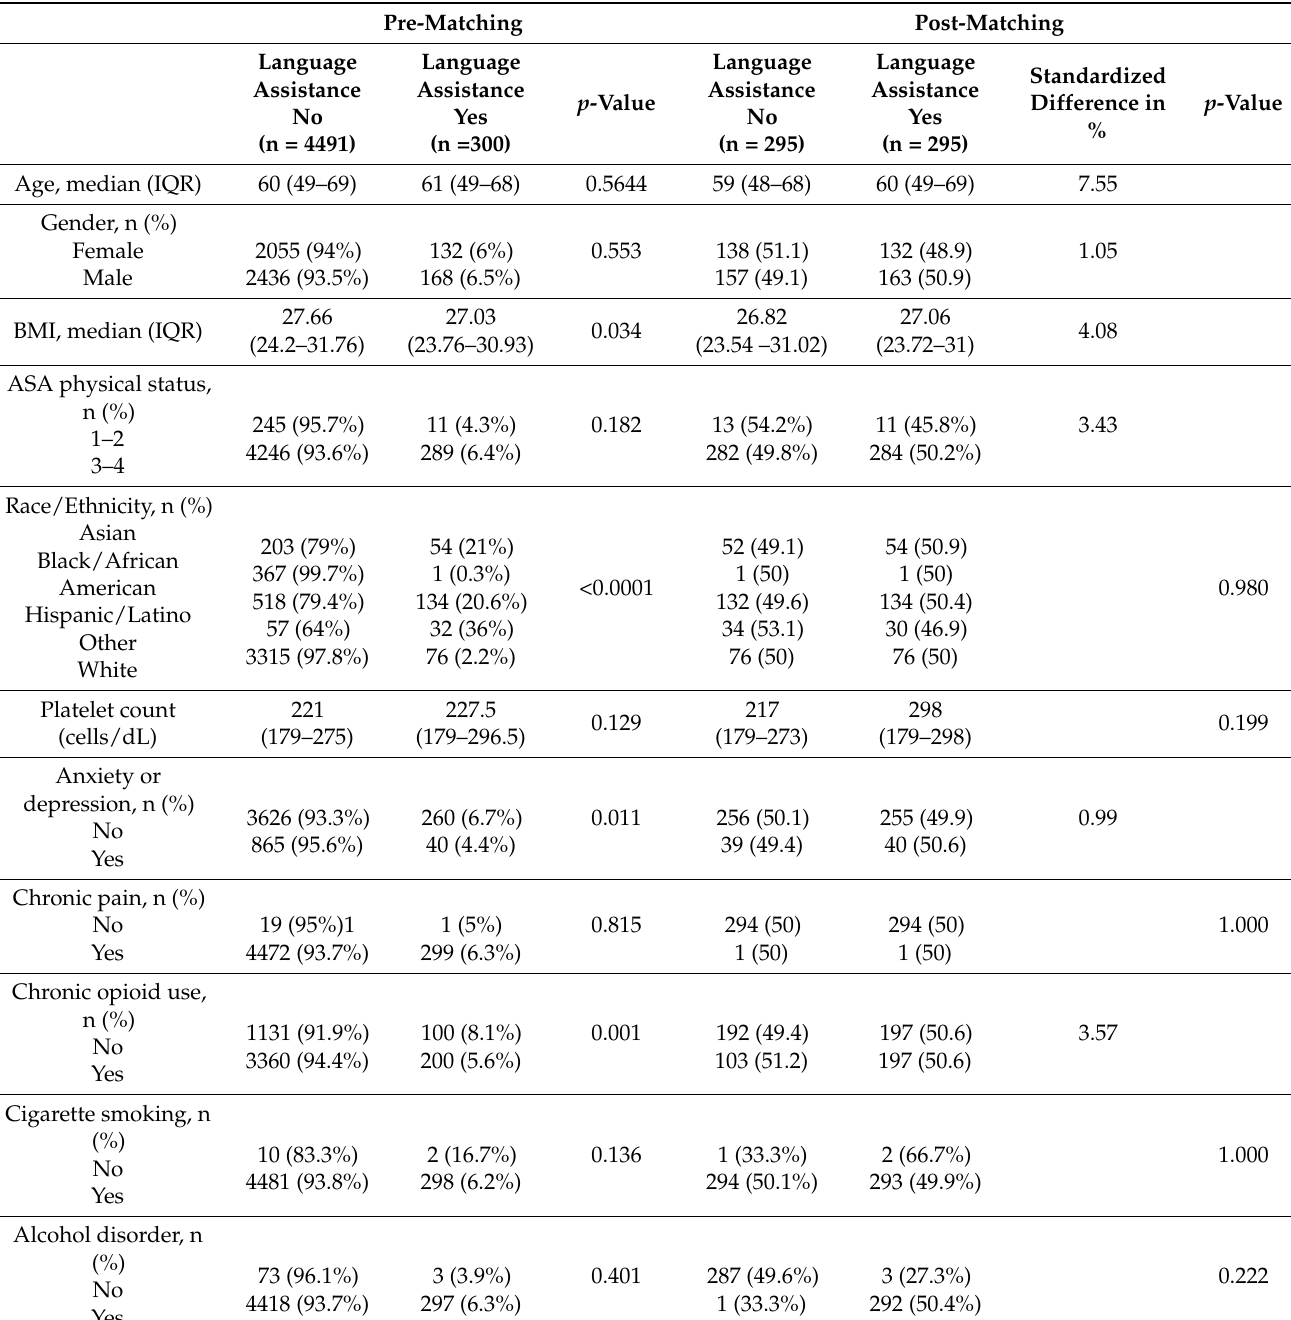
Table 1. Perioperative characteristics of adults undergoing open abdominal